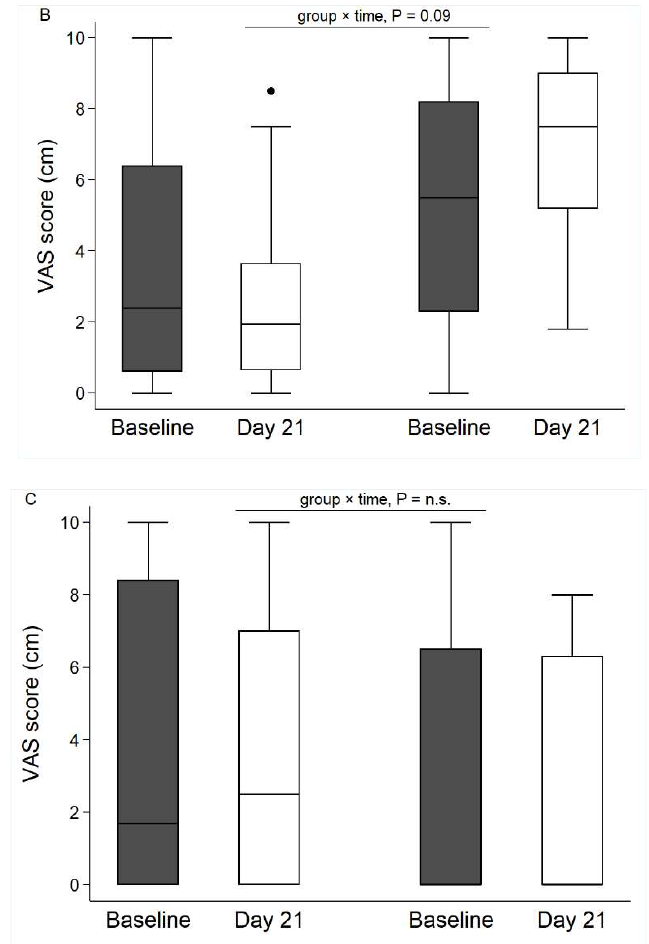
Figure 2. Visual analogue scale (VAS) score for gastrointestinal symptoms. VAS for abdominal pain ( A ), fecal consistency ( B ), and post-prandial fullness severity ( C ). In each plot, data is shown as median (line), inter-quartile range (box limits), and min/max (whiskers); Black dot in B) indicates an extreme value. R-GFD: regular gluten-free diet; LF-GFD: low-FODMAP gluten-free diet; and n.s.: non-significant.